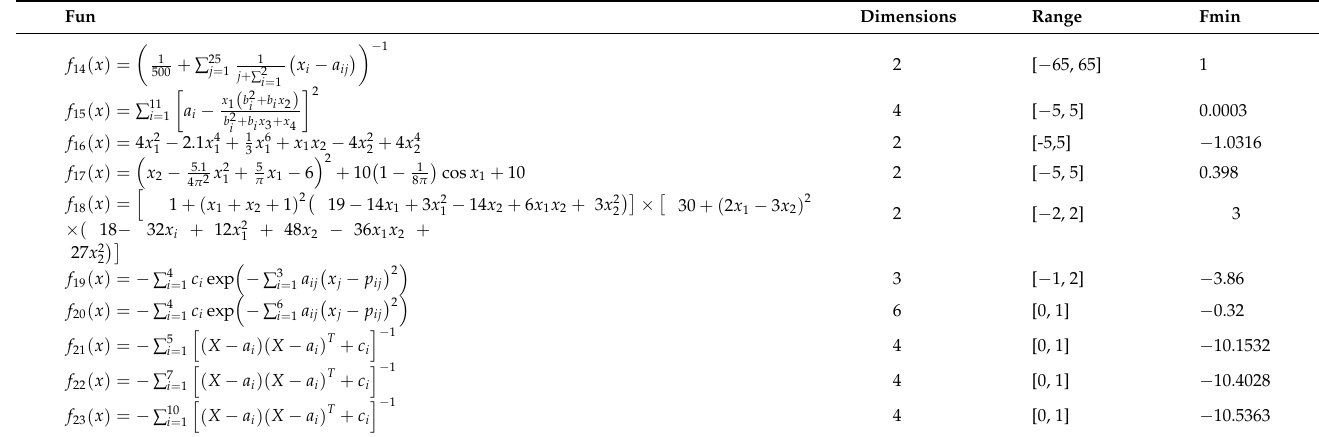
Table 4. Fixed-dimension multimodal benchmark